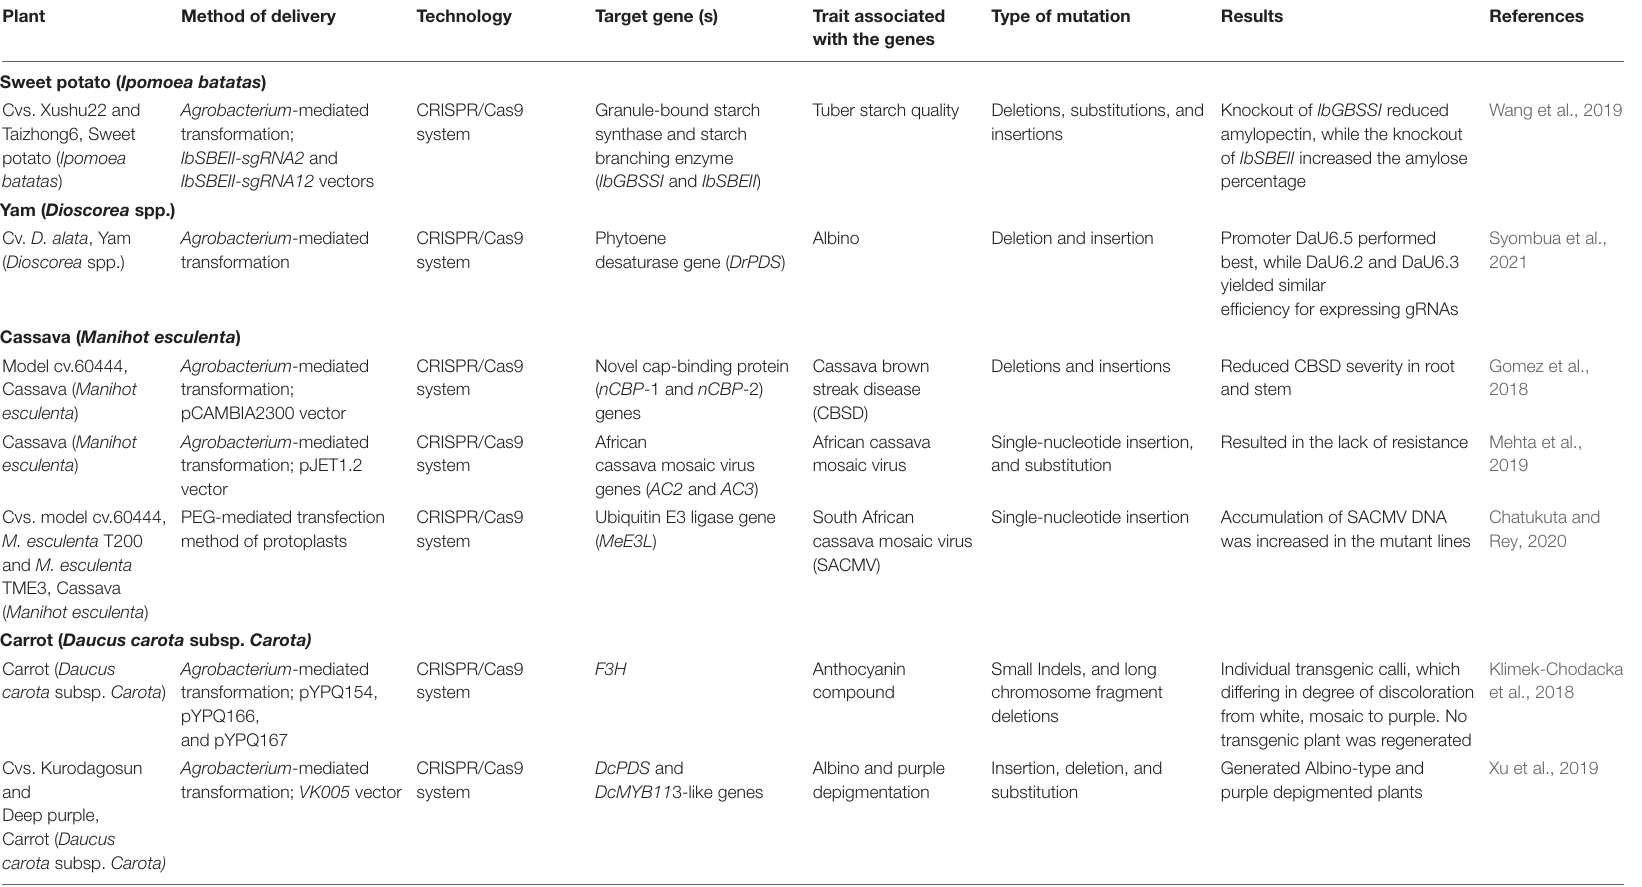
TABLE 2 | Application of CRISPR/Cas system in sweet potato ( Ipomoea batatas ), cassava ( Manihot esculenta Crantz ), yam ( Dioscorea spp.), and carrot ( Daucus carota subsp. sativus ).